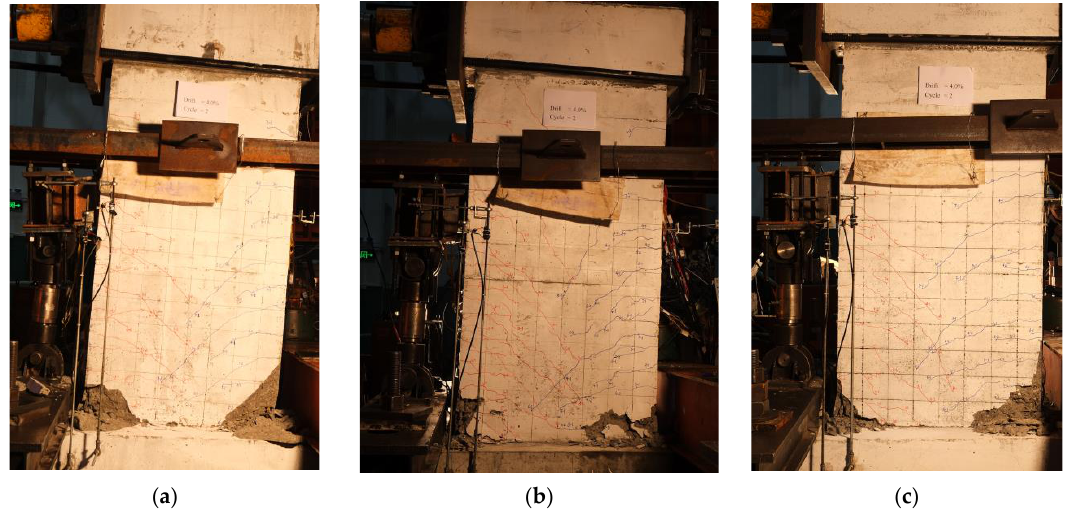
Figure 13. Ultimate conditions of wall piers ( θ = 4.0%). ( a ) Wall pier in CS-1; ( b ) Wall pier in CS-2; ( c ) Wall pier in CS-3.